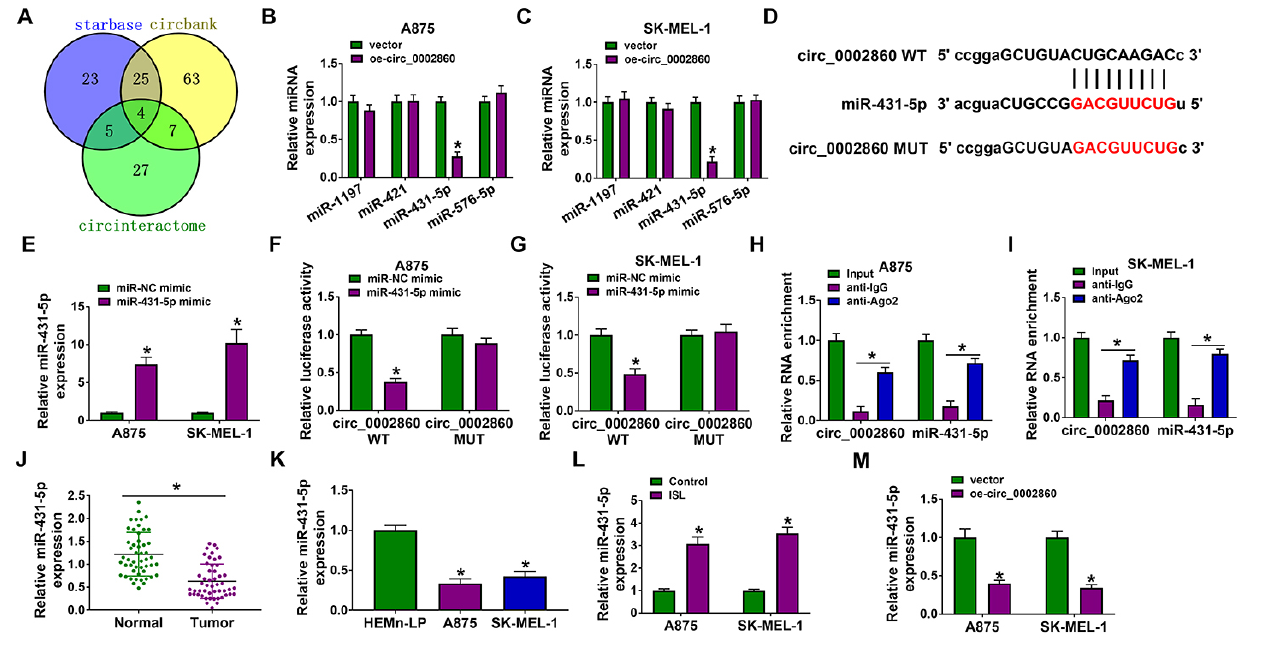
Figure 3. Circ_0002860 induced the sponge effect on miR-431-5p. (A) Venn Diagram was applied to select the mutual miRNAs by starbase, circbank and circinteractome. (B, C) The miR-1197, miR-421, miR-431-5p and miR-576-5p levels were examined by RT-qPCR after A875 and SK-MEL-1 cells were transfected with vector or oe-circ_0002860. (D) The binding region between circ_0002860 and miR-431-5p in starbase. (E) The transfection efficiency of miR-431-5p mimic was assessed using RT-qPCR. (F-G) Dual-luciferase reporter assay and (H-I) RIP assay were used to analyze the combination of circ_0002860 and miR-431-5p. The miR-431-5p quantification was performed using RT-qPCR in (J) melanoma samples and (K) cells. (L) The level of miR-431-5p was measured by RT-qPCR in 60 µg/ mL ISL-treated A875 and Sk-MEL-1 cells. (M) The miR-431-5p expression was detected by RT-qPCR after transfection with vector or oe-circ_0002860. * p <